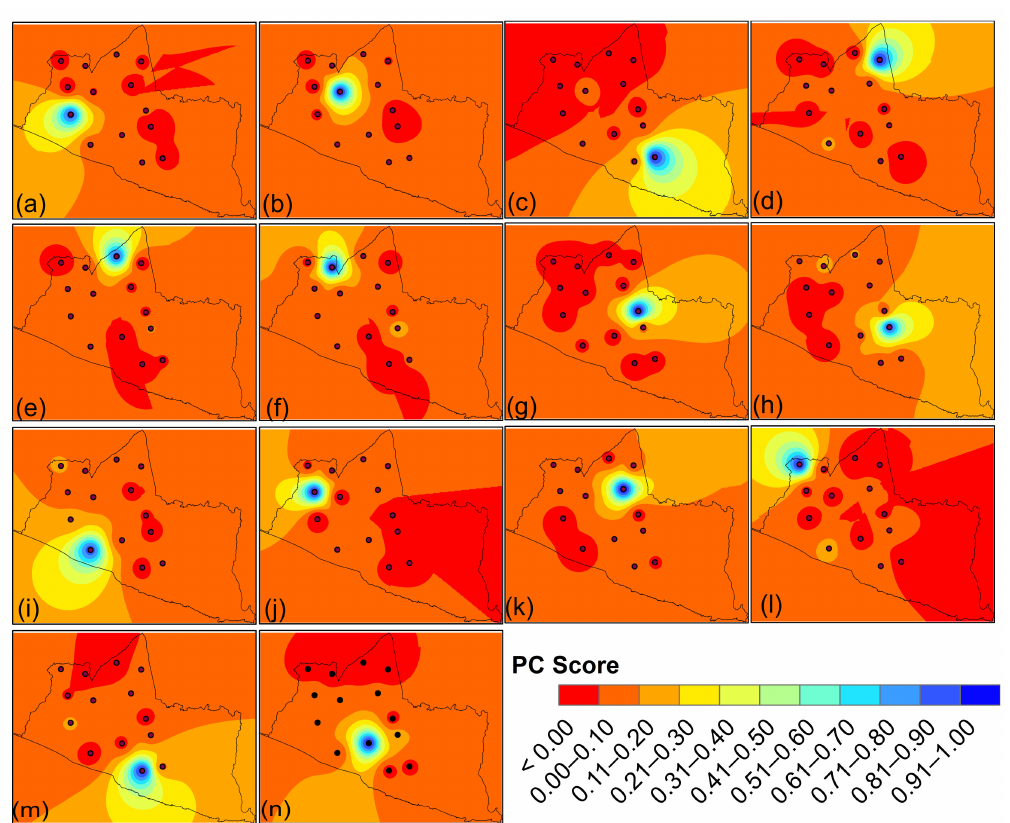
Figure 7. Spatial distribution of monthly rainfall that resulted from principal component analysis in the rainy season with ( a ) PC1; ( b ) PC2; ( c ) PC3; ( d ) PC4; ( e ) PC5; ( f ) PC6; ( g ) PC7; ( h ) PC8; ( i ) PC9; ( j ) PC 10; ( k ) PC11; ( l ) PC12; ( m ) PC13; ( n ) PC14